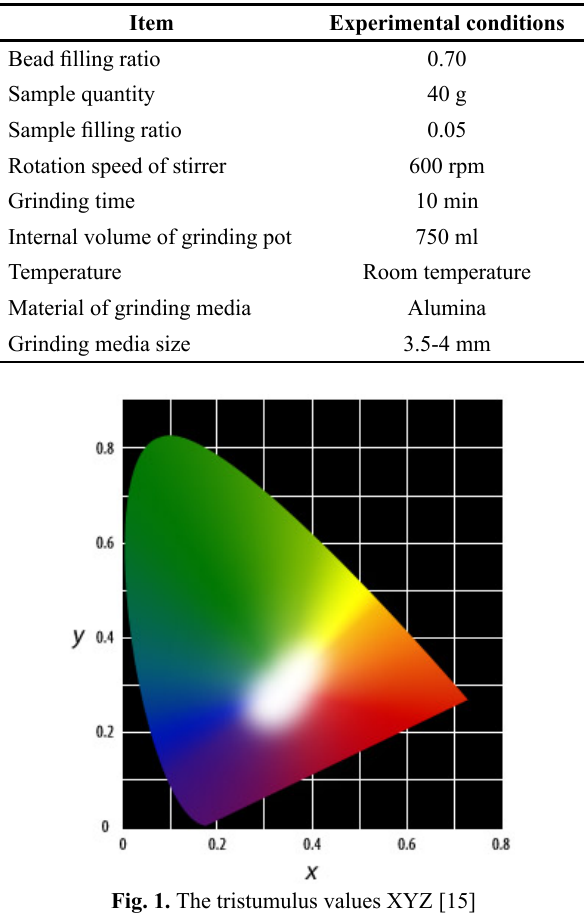
Table 3 .Summary of experimental conditions